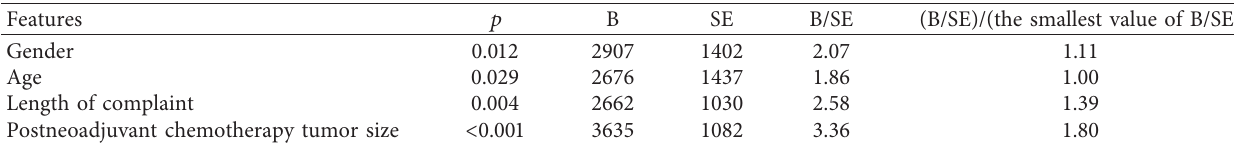
Table 3: Multivariate analysis of clinical features and laboratory parameters with histopathological response based on Huvos grading system, and value of B and SE in each variable based on logistic regression analysis